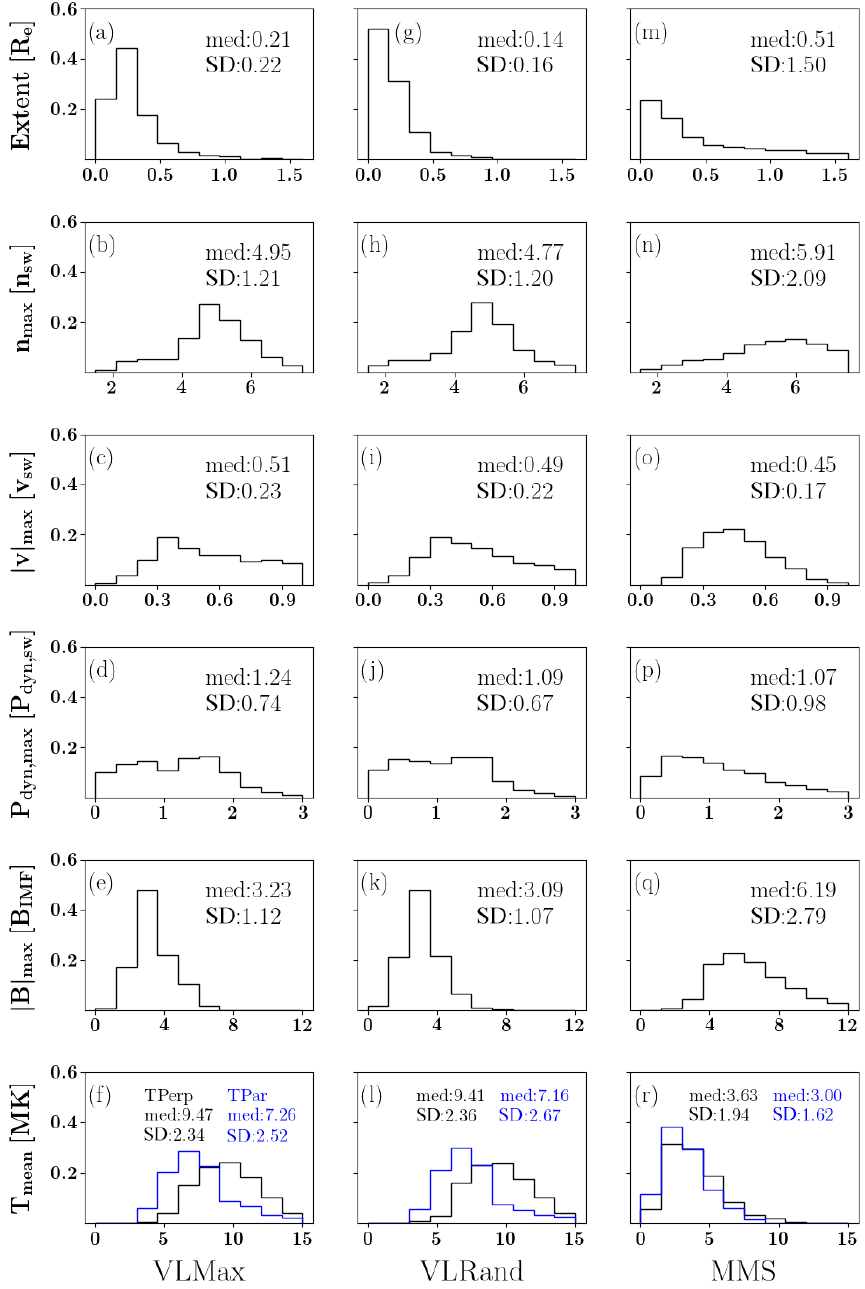
Figure 5. Histograms of Vlasiator (two first columns) and MMS jets (third column) at times and positions specified in Fig. 4. From top to bottom we present histograms of the jet total extent, maximum density, maximum velocity, maximum dynamic pressure, maximum magnetic field intensity, and maximum temperature. The extent is given in Earth radii and the temperature in megakelvins; however, all other parameters are given as normalised to the respective solar wind and IMF values. The bottom row gives both the parallel and perpendicular temperatures in blue and black, respectively. The top right corner of each panel gives the median and standard deviation of the respective histogram.